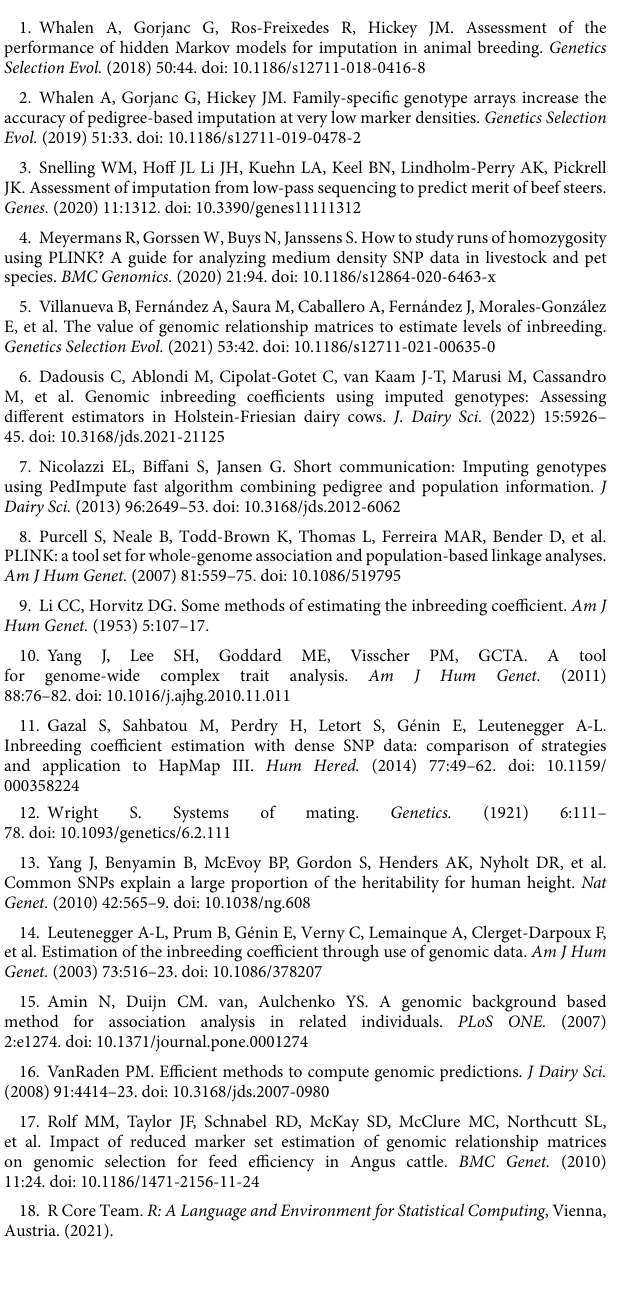
correlation, in red correlations estimated from the genotyped SNP in each panel and in green correlations estimated from the imputation